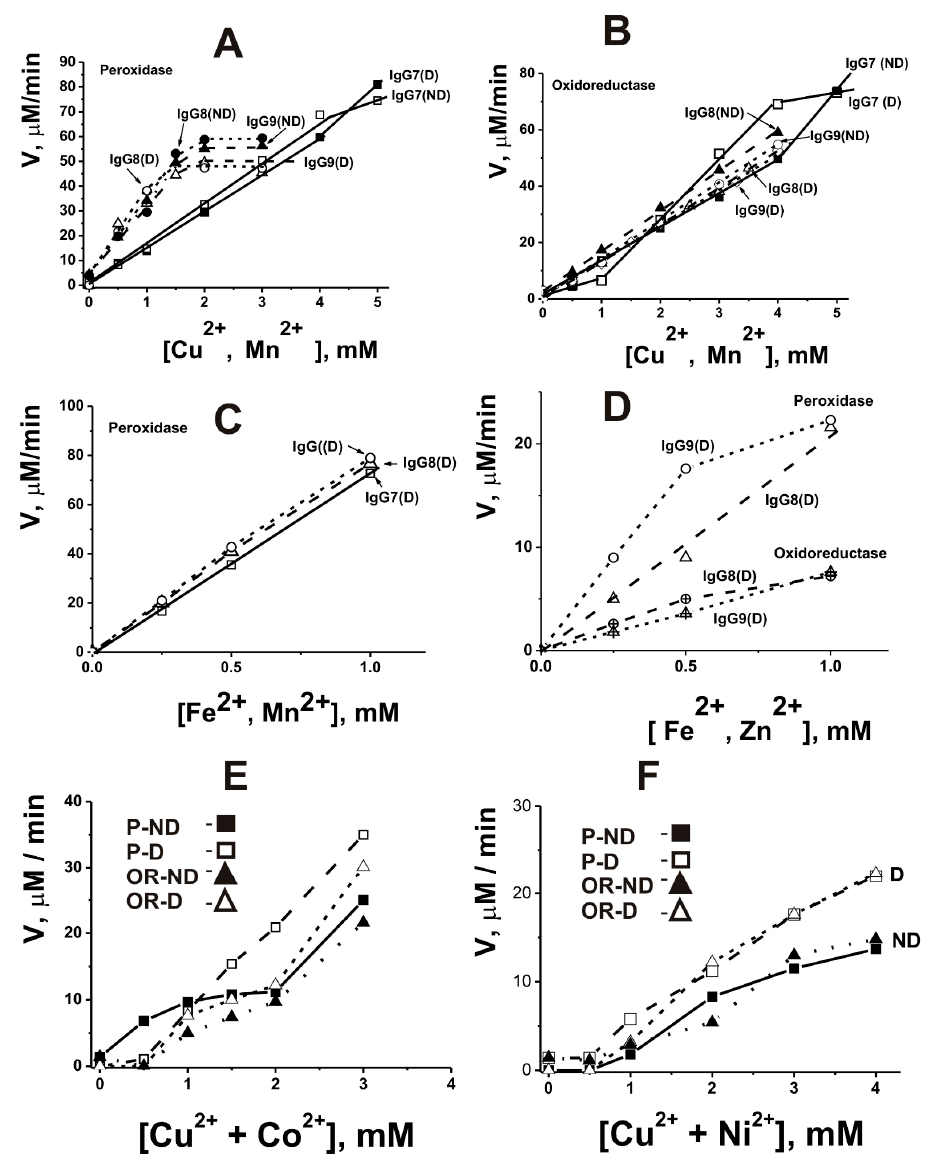
Figure 5. Dependencies of the peroxidase and oxidoreductase activities in the IgG-dependent oxidation of DAB (0.2 mg/mL) on the concentration of equimolar mixtures of MnCl 2 with CuCl 2 ( A , B ), FeCl 2 with MnCl 2 or ZnCl 2 ( C , D ); CuCl 2 with CoCl 2 ( E ); NiCl 2 ( E ); or NiCl 2 ( F ). Curves corresponding to dialyzed (D) and non-dialyzed (ND) IgGs (5 µg/mL) and the numbers of IgG preparations are marked in Panels ( A – F ). Additional designations in ( E , F ) panels refer to non-dialyzed and dialyzed (P-ND and P-D) peroxidase and non-dialyzed and dialyzed (OR-ND and OR-D) oxidoreductase activities of IgGs [172].